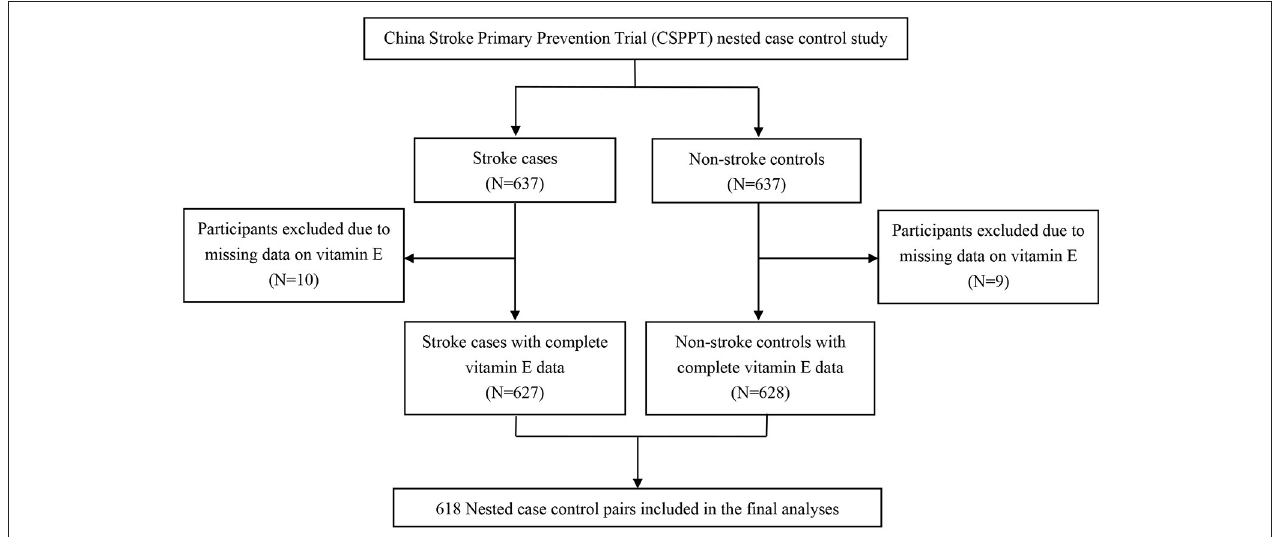
FIGURE 1 | Flow chart of the study participants: A nested case control design based on the China Stroke Primary Prevention Trial